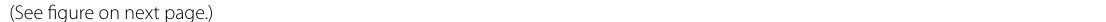
solution on PC from 1 g CDW of Bacillus sp. LPPI-18 is that isolated from sediment. c Recovery of PCs using SDS (3%) and NaOCl solution and recovery level of PCs with 6.25 M NaCl and NaOCl solution. Data represented the